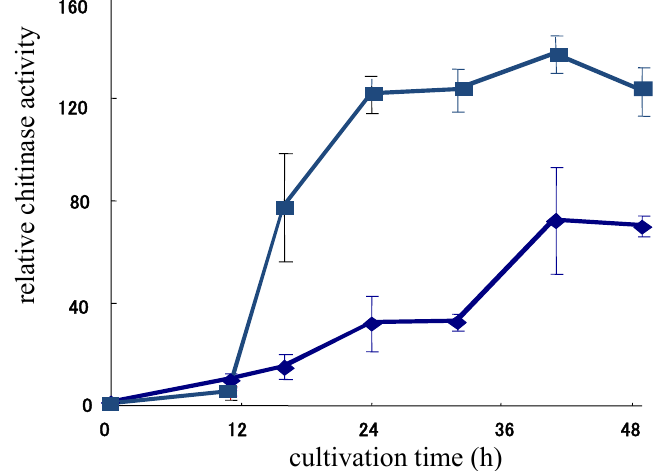
Figure 3. Chitinase production of Streptomyces sp. AJ9463 with ( ■ ) or without ( ◆ ) allosamidin (2 μ M) in colloidal chitin